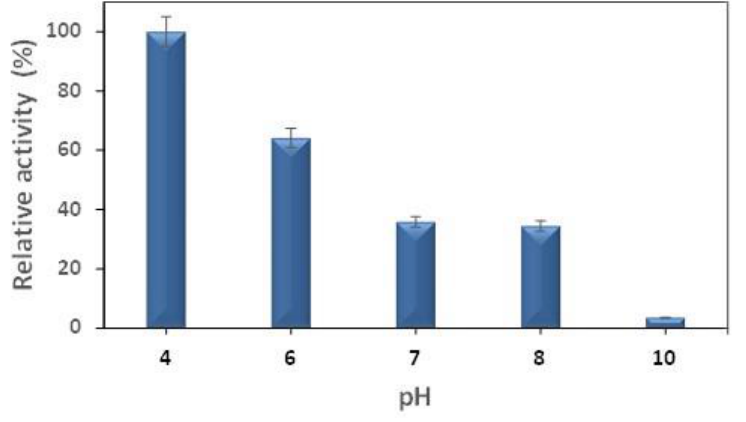
Figure 3. Effect of pH variation on BCL immobilization process.